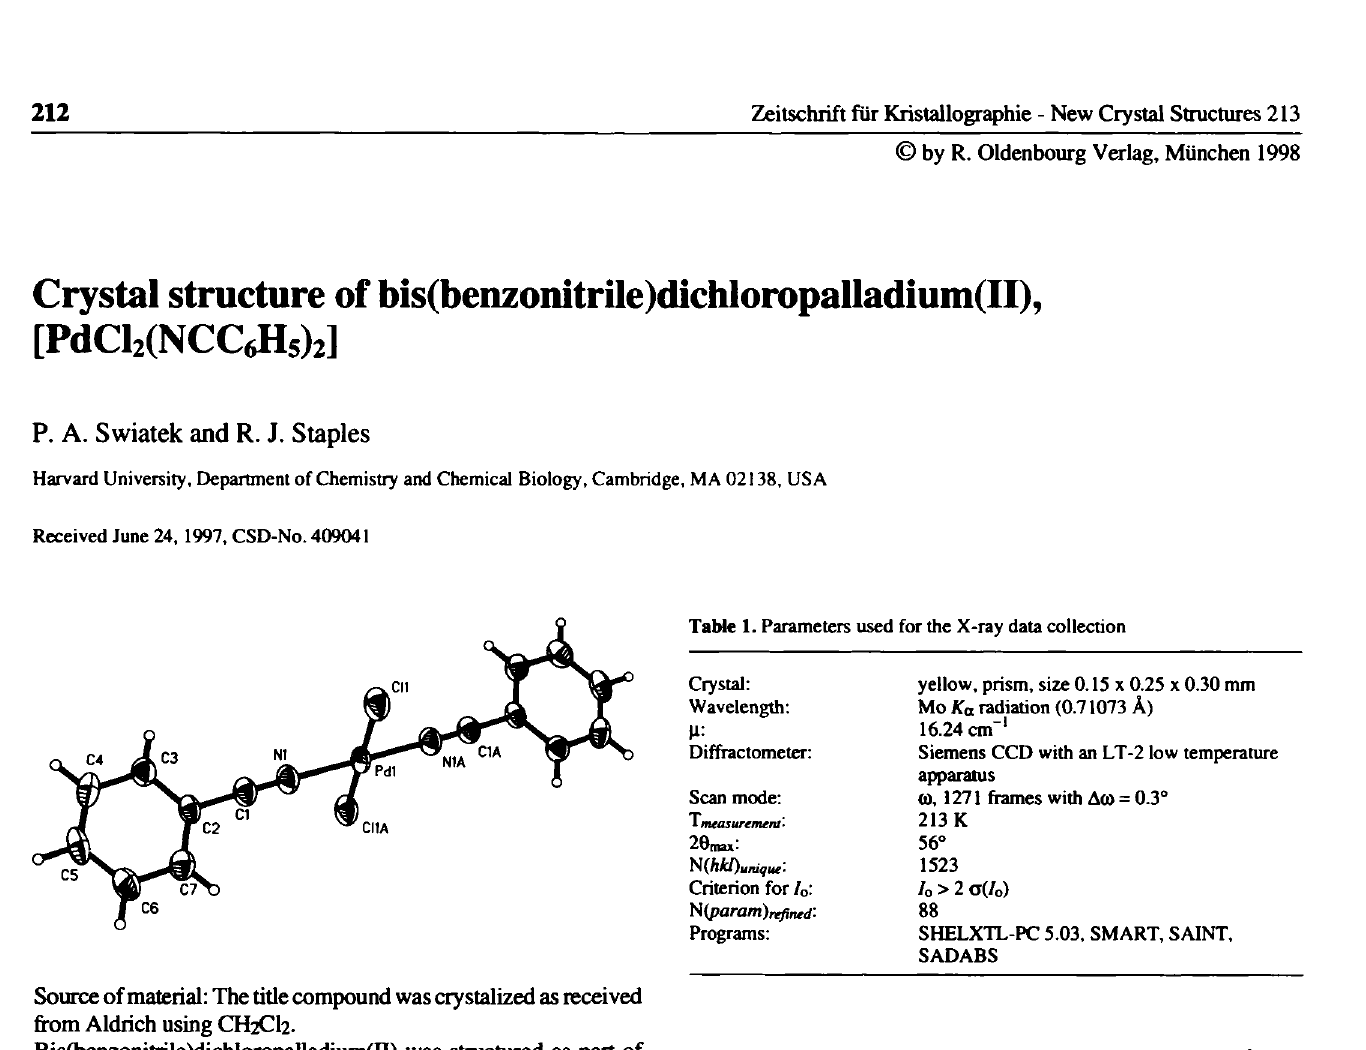
Table 2. Final atomic coordinates and displacement parameters (in Â^)